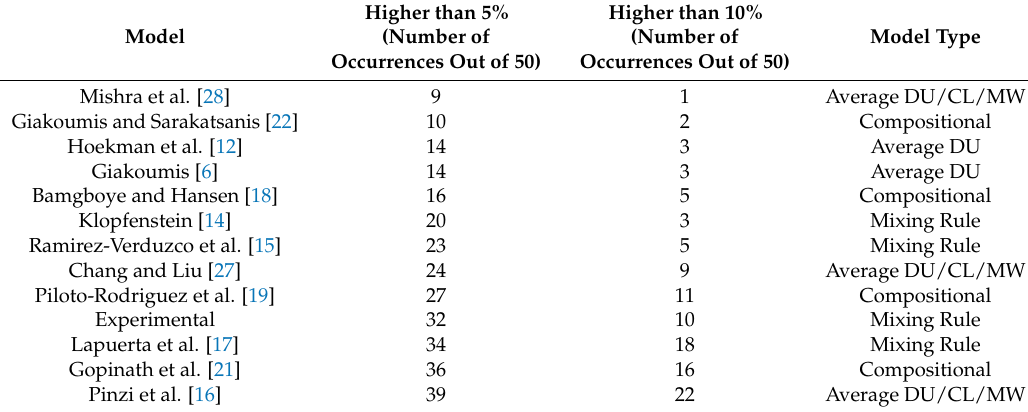
Table 6. Errors from all models (based on the data from Table